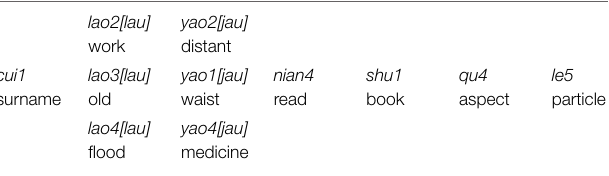
TABLE 4 | The first set of the stimuli in which the numbers of the syllables represent the five lexical tones in Mandarin: 1 for H (High tone), 2 for R (Rising tone), 3 for L (Low tone), 4 for F (Falling tone), and 5 for N (Neutral tone).